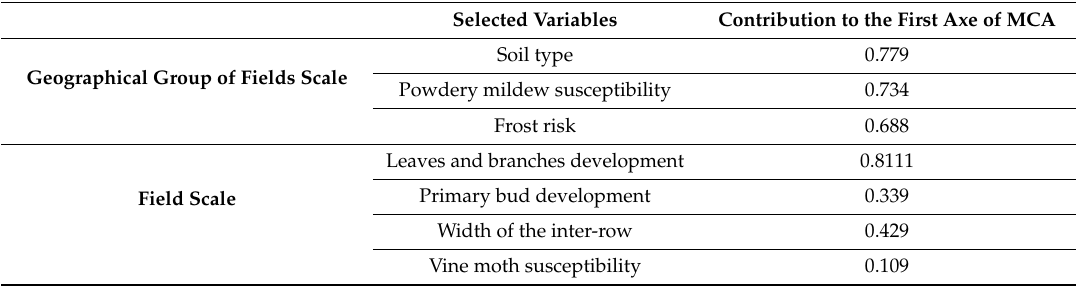
Table 2. Results of the MCA analysis-contribution of the selected variables to the first axe of